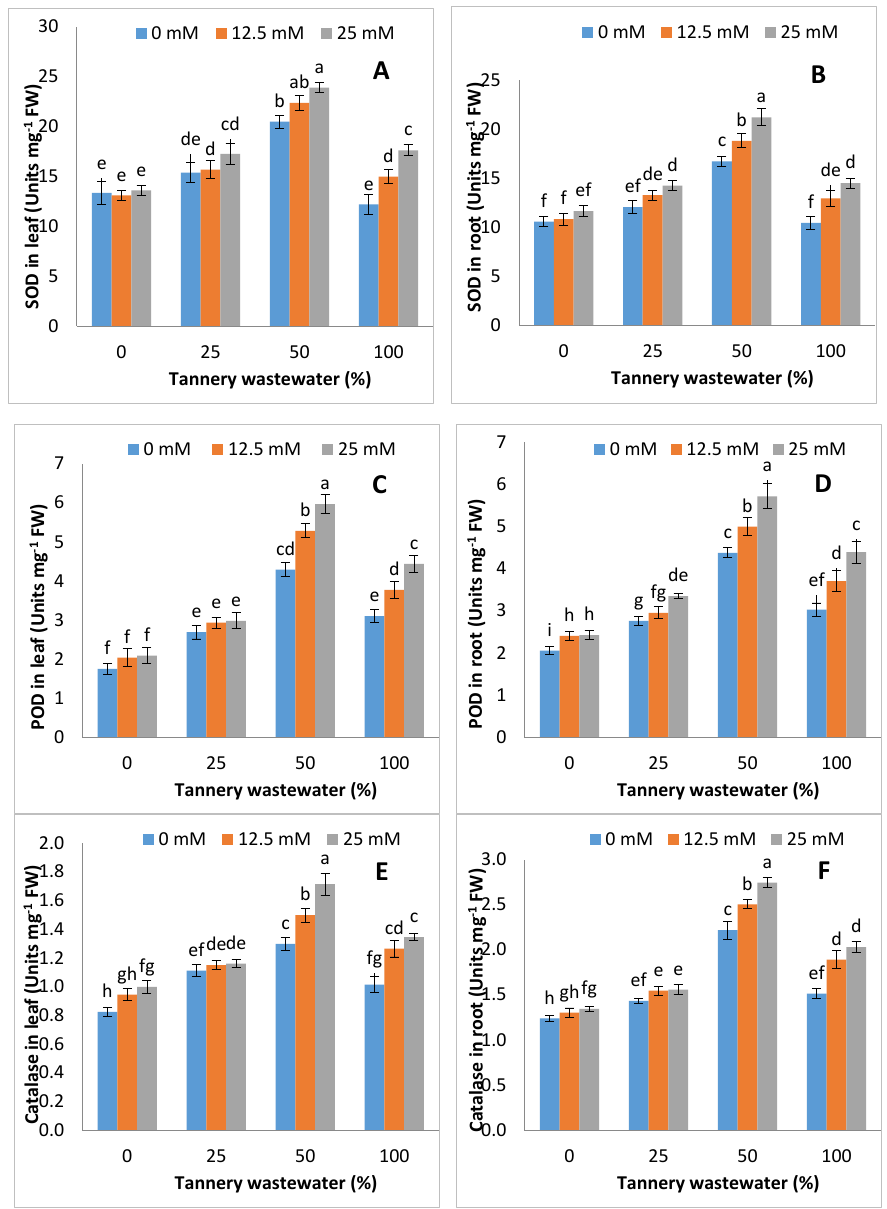
Figure 6. Graphs showing effect of foliar spray of zinc chelated lysine (0, 12.5, 25 mM) on superoxide dismutase (SOD), peroxidase (POD) and catalase (CAT), in leaves ( A , C , E ) and roots ( B , D , F ) of maize plants growing under 0%, 25%, 50%, 100% concentration of tannery wastewater. Value are means of three replicates. Statistical analyses were carried out by ANOVA, followed by Tukey’s Post-Hoc